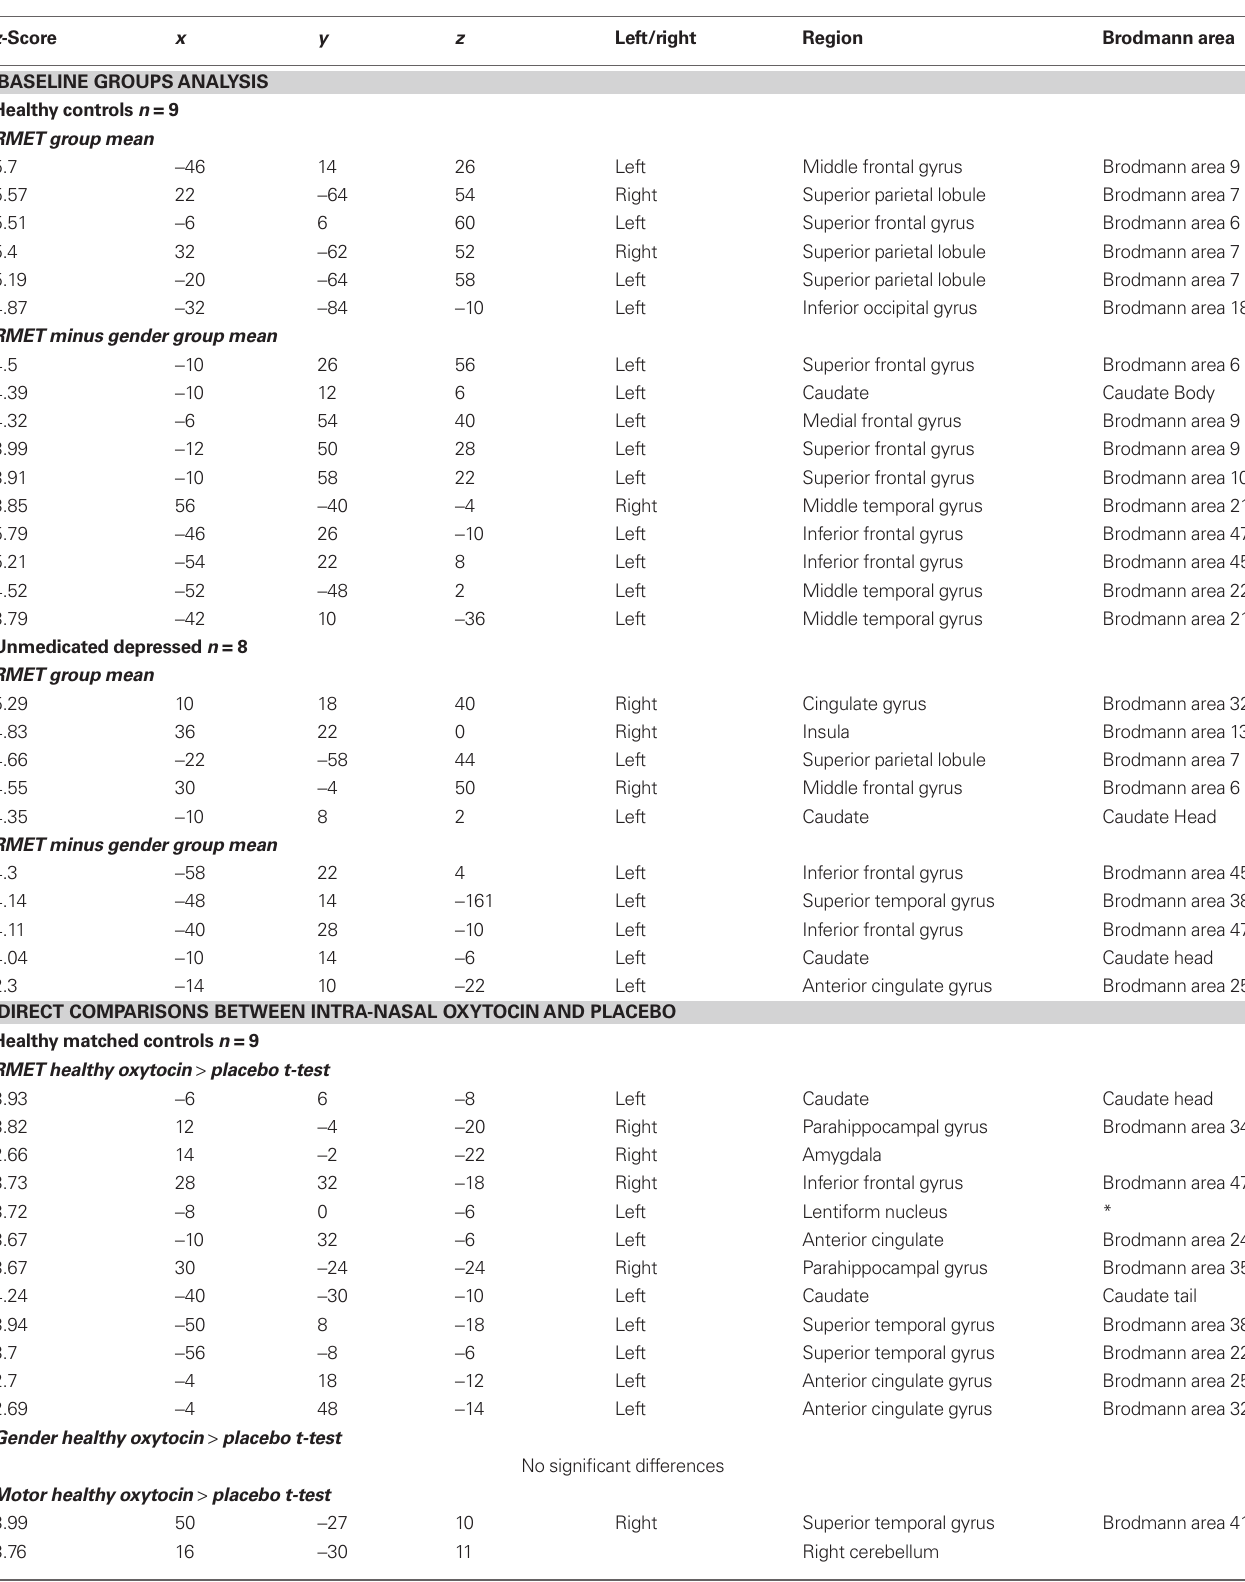
Table 3 | fMRI activations Talairach coordinates and corresponding z